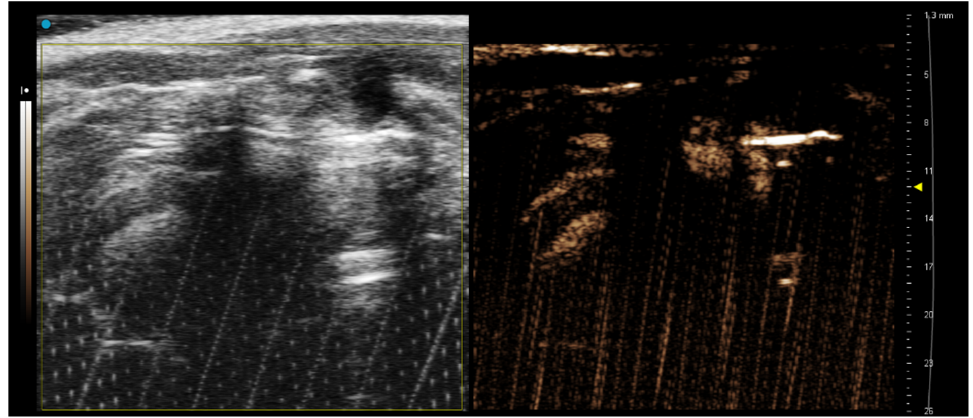
Figure 4. NLC imaging of rat heart 5 s after administration of Vevo MicroMarker contrast agent in PSLAX view. The rat was cannulated in the infrarenal aorta. A successful administration of Vevo MicroMarker contrast agent in B-Mode ( left ) and NLC Mode ( right ) was detectable in the RA and LV and